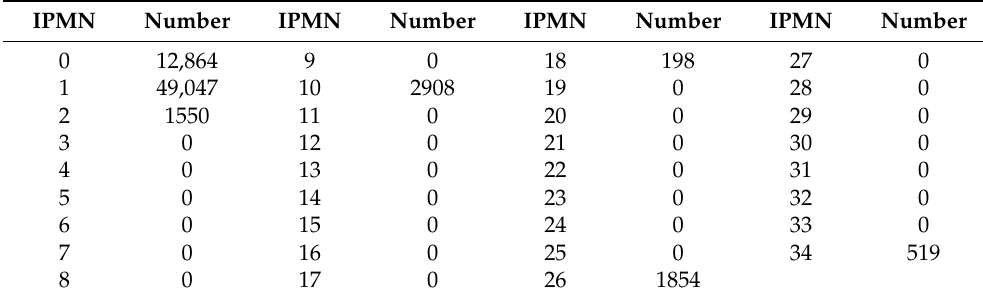
Table 3. Example of intra 2 N × 2 N prediction modes of 32 × 32 CU in HEVC encoder’s descriptor. Here, IPMN stands for intra prediction mode